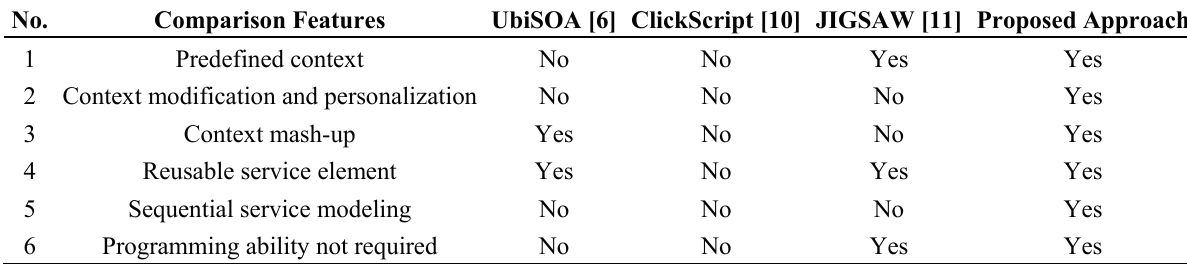
Table 2. Comparison features